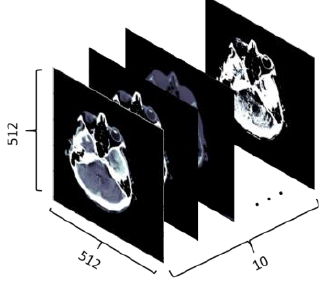
Figure 4. DICOM files under different window settings create a temporal sequence.